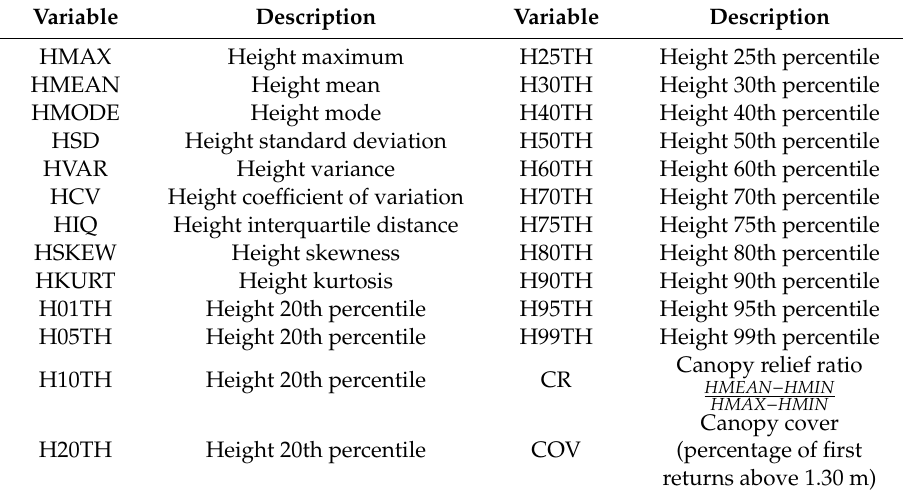
Table 3. LiDAR-derived structure metrics considered as candidate predictor